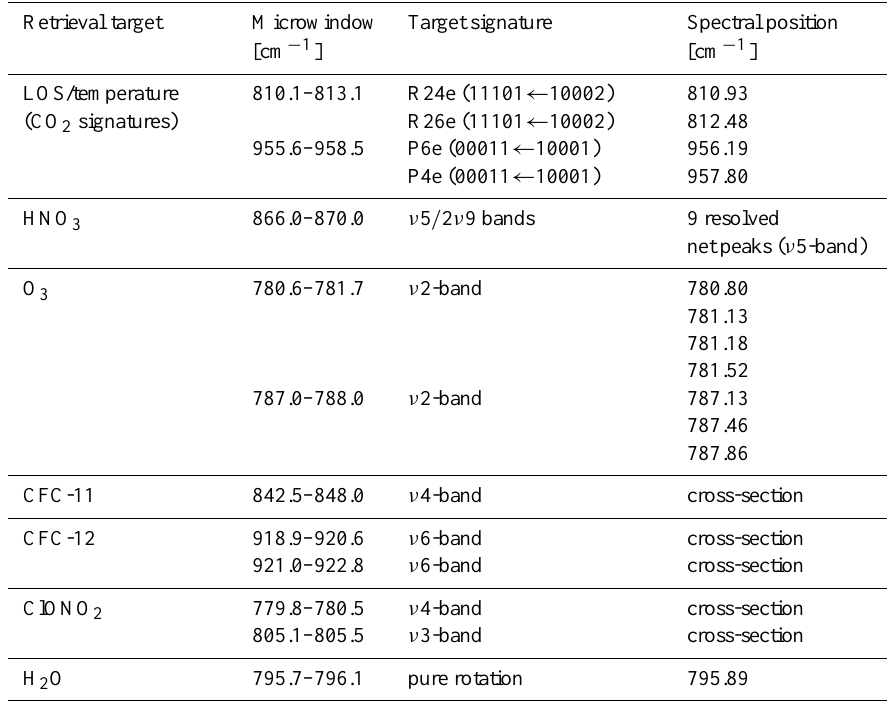
Table 2. Microwindows and target signatures selected for the retrievals. Spectral positions of the most prominent target signatures are listed. For cross-section gases, the spectral signatures are relevant in the whole range of the